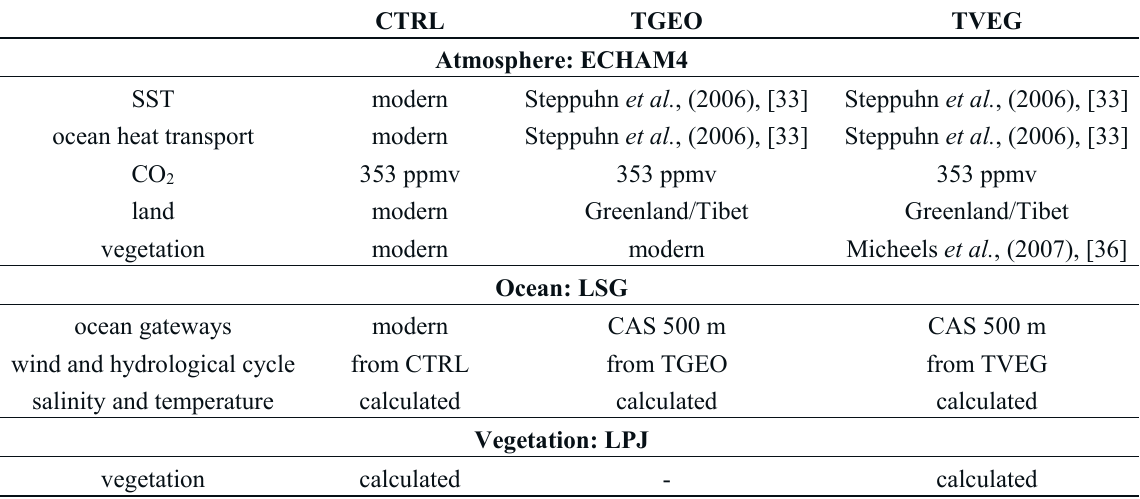
Table 1. List of